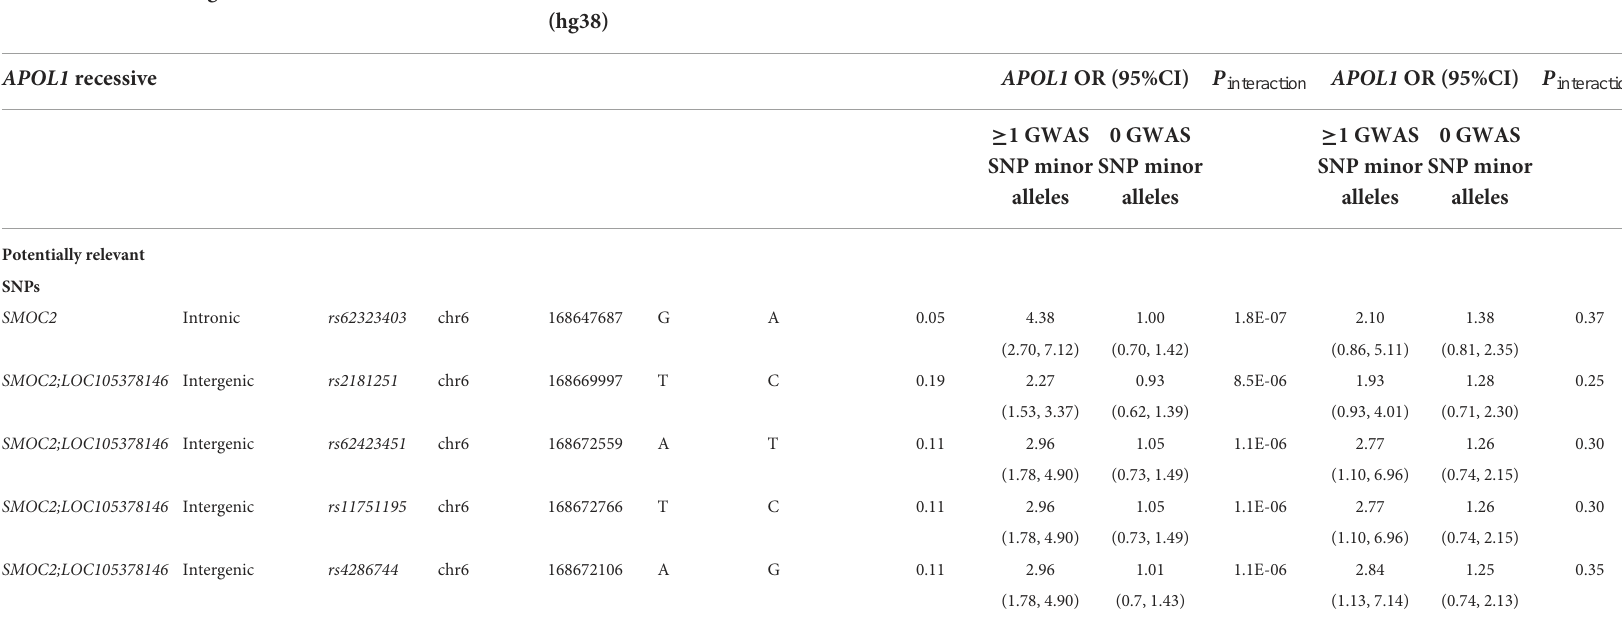
TABLE 3 Top APOL1–SNP interaction effects on ESKD in the REGARDS and GenHAT studies under APOL1 recessive model.